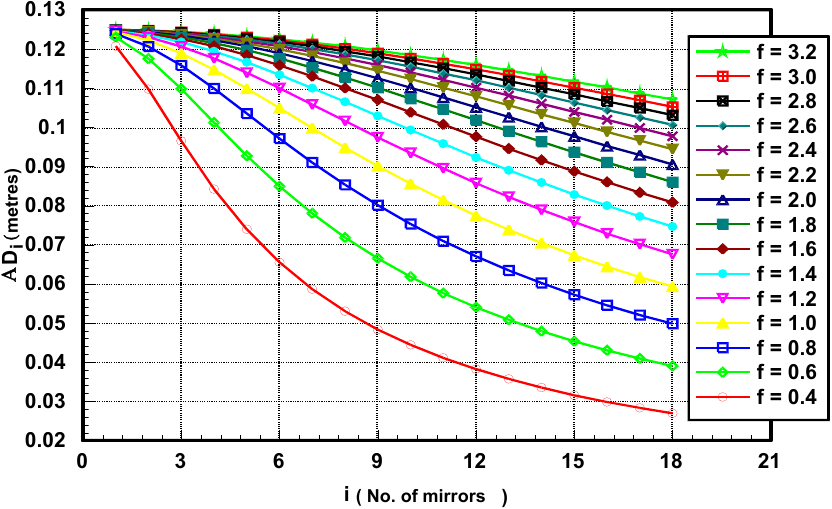
Figure 4. Variations in the width of mirror plotted against number of mirrors with different focusing distances (F) of concentrator apparatus, absorber width a = 0.125 m.